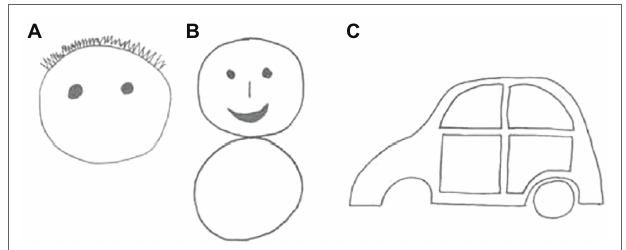
FIGURE 1 | Stimuli used for the drawing completion task: (A) face, (B) human figure, and (C) car; (A) and (B) adapted from Freeman (1980); (C) adapted from Yamagata